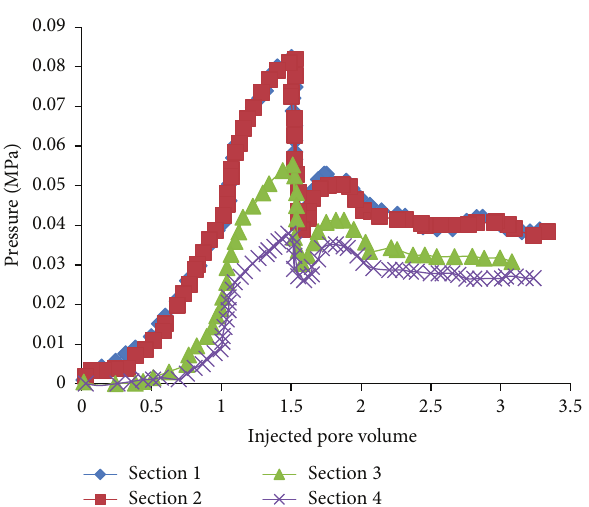
Figure 16: The plot of the injection pressure (diameter: 0.08– 0.1 mm, concentration: 3000 mg/L).